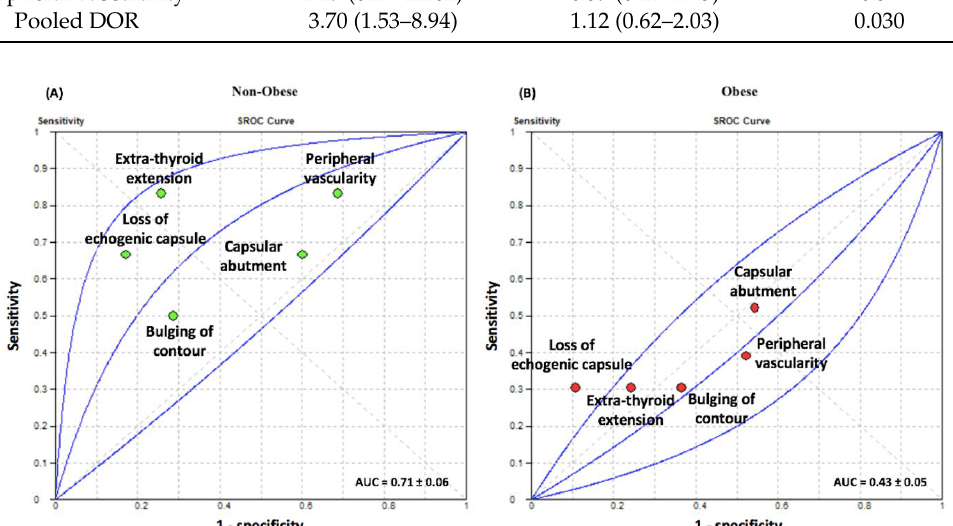
Figure 2. Receiver operating curve (ROC) of sonographic features in assessing for ETE. The summary receiver operating curve for ( A ) non-obese and ( B ) obese patients are depicted. Area under the curve is reported with corresponding a standard error. ETE: subjective suspicion of ETE, Capsular: abutment of the capsule, Contour: bulging of thyroid contour, Echogenic: loss of echogenic capsule, Vascularity: extension of vascularity beyond thyroid capsule. sROC: summary receiver operating curve; AUC: area under the curve.